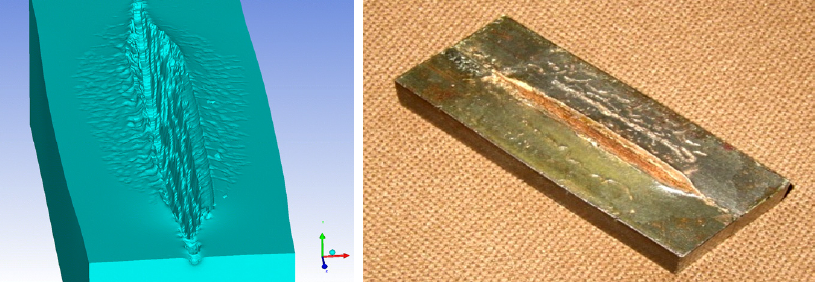
Figure 4. Top view of target at OSD (left: simulation result, right: a general testing